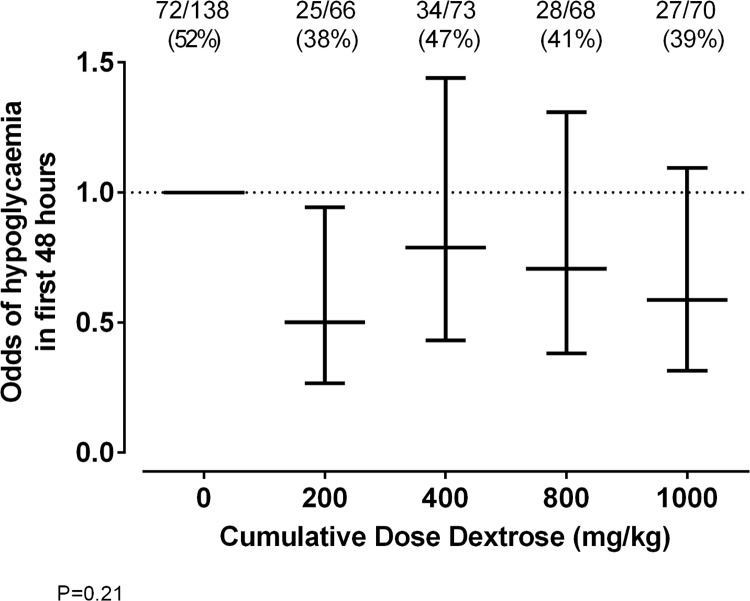
Odds of hypoglycaemia for each cumulative dose of prophylactic dextrose gel.Odds ratios of blood glucose concentration < 2.6 mM for each cumulative dose of prophylactic dextrose gel, where 0 mg/kg is placebo, 200 mg/kg is 0.5 ml/kg dextrose once, 400 mg/kg is 1 ml/kg once, 800 mg/kg is 0.5 ml/kg for four doses, and 1,000 mg/kg is 1 ml/kg once followed by 0.5 ml/kg for a further three doses. Data are odds ratios +/− 95% CI adjusted for prespecified potential confounders (sex, gestational age, and delivery mode), and the numerals above the figure are the number (%) of babies who experienced hypoglycaemia (blood glucose concentration < 2.6 mM) in each group.